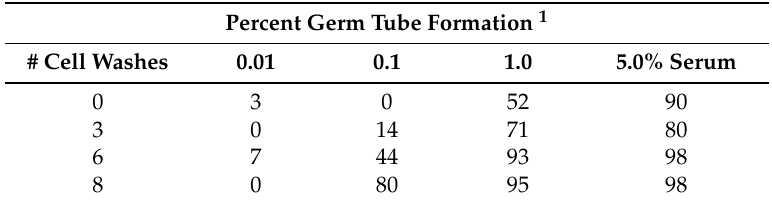
Table 3. Effect of cell washings on serum-induced germ tube formation in C. albicans.